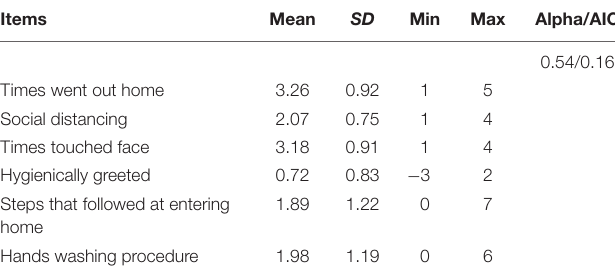
TABLE 2 | Reliability and univariate statistics of precautionary behavior scale.